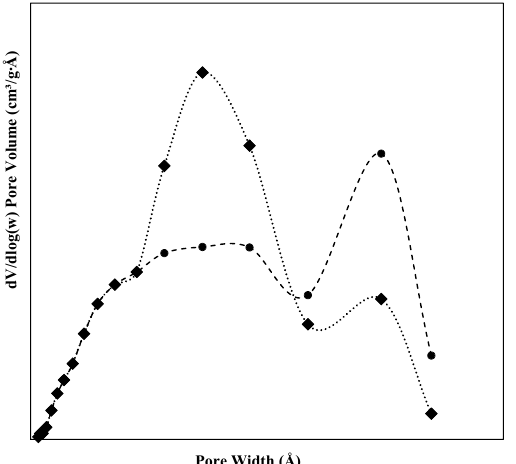
Fig. 4. The pore size distribution (PSD) of the graphene oxide ( ■ ) and g-C